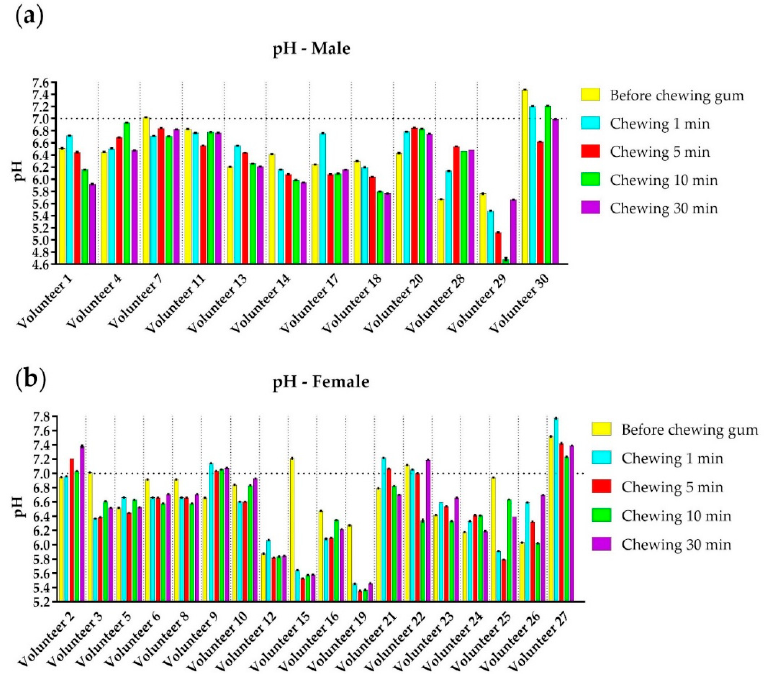
Figure 3. Results of pH measurements for each volunteer ( a ) male, ( b ) female. A horizontal line on graphs corresponds to neutral pH and vertical lines separate each volunteer.